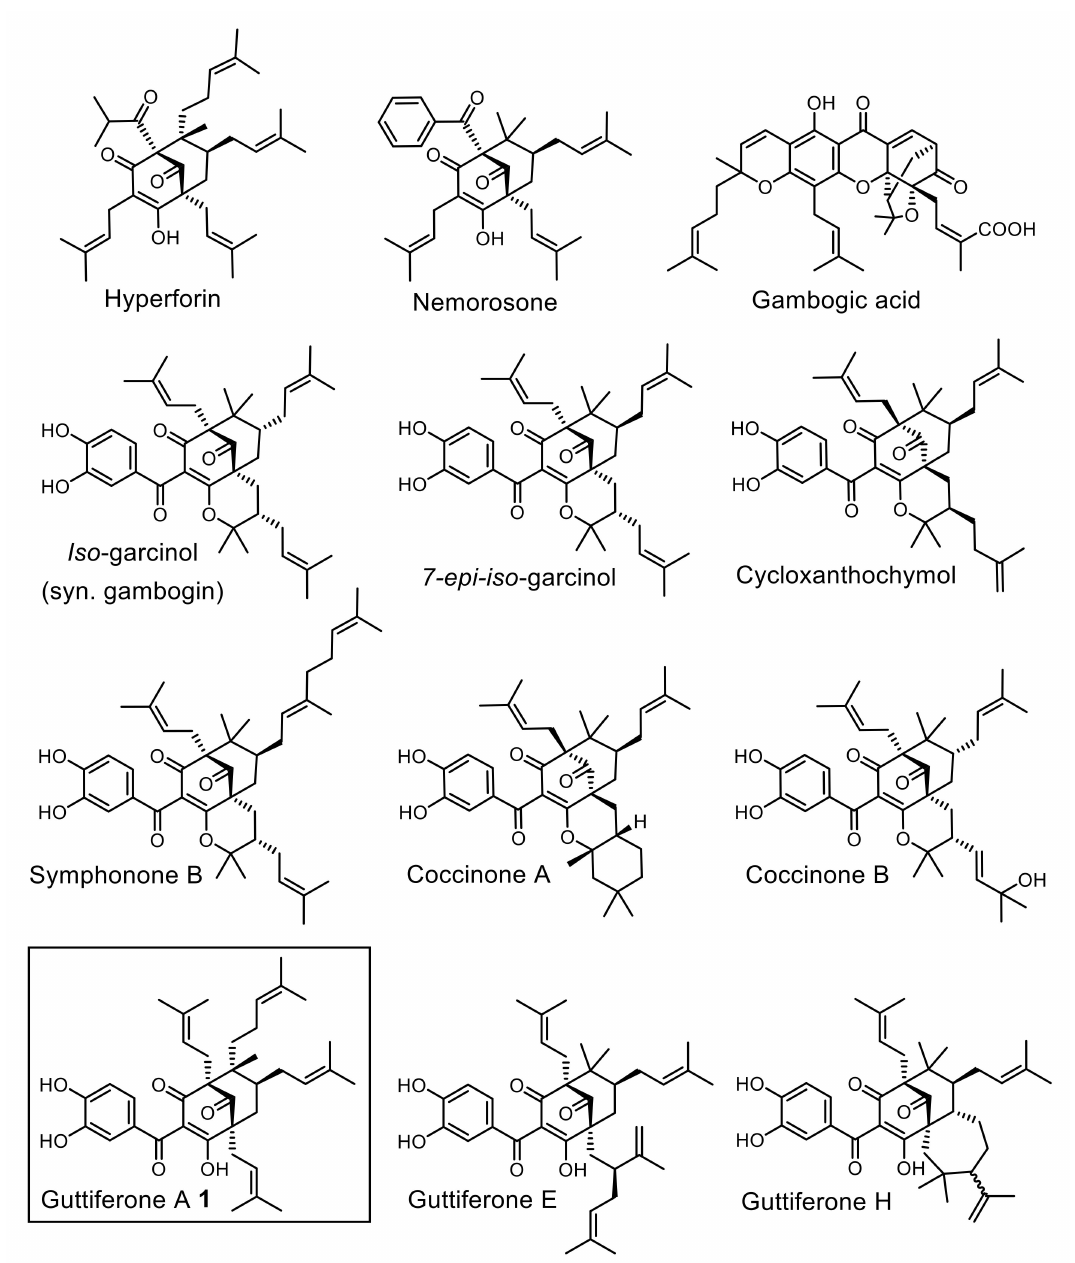
Figure 1. Representative antimalarial PPAPs (IC 50 = 0.2 to ca. 5 µ M in